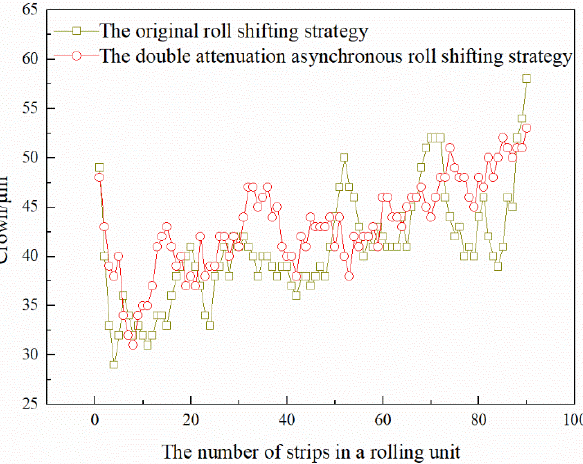
Figure 17. Comparison of strip crown after double attenuation asynchronous roll shifting strategy.